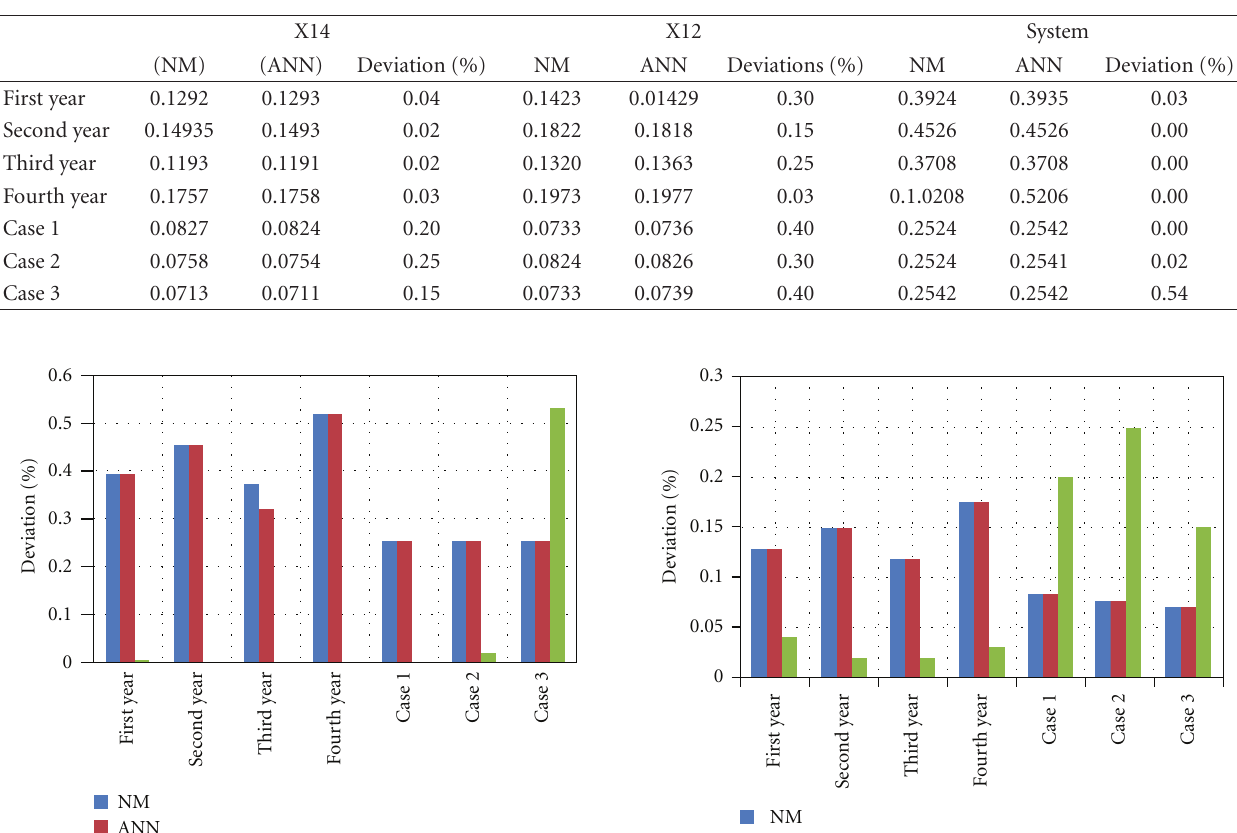
Table 3: System average interruption duration index values (SAIDI).